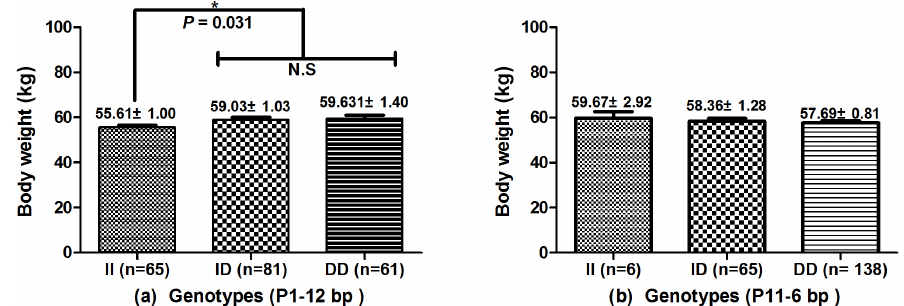
Figure 3. Association of the P1-12-bp and P11-6-bp indel with body weight in SWCG. (a) Individuals with ID and DD genotypes have significantly higher body weight than the II genotype in the P1-12-bp indel ( P = 0 . 036). (b) There is no significant difference between the P11-6-bp indel and body weight in SWCG. Data represent means ± SE. N.S – not significant. *: P < 0 .